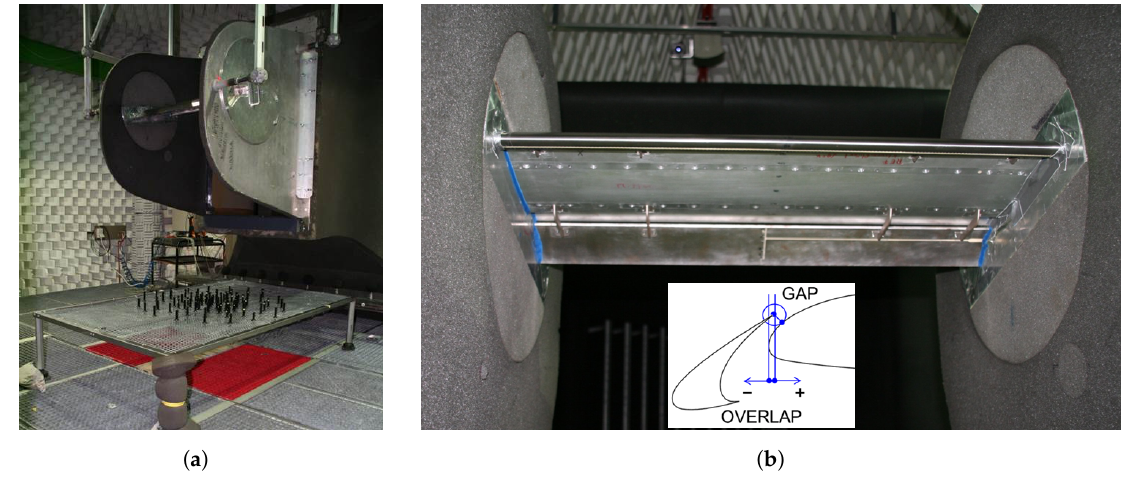
Figure 4. AWB (Acoustic Wind Tunnel Braunschweig) test arrangement for high lift airfoil F16 and detailed view of installed F16 (slat in front). ( a ) F16 airfoil in AWB (side view); ( b ) F16 airfoil pressure side in AWB (view from upstream); defintion of overlap and